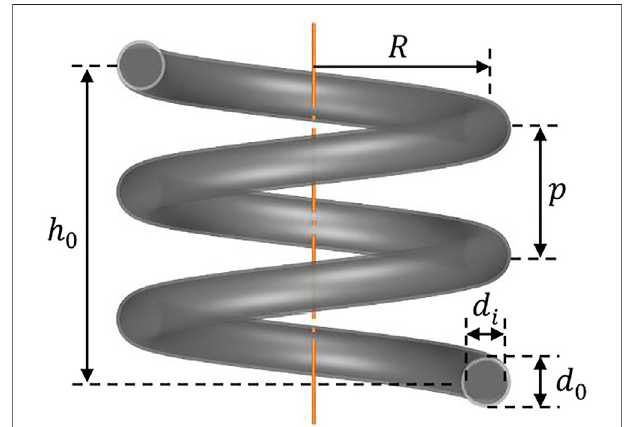
FIGURE 2 | (A) Spring-solenoid system and generated magnetic fi eld, (B) in-plane magnetic fi eld produced by the solenoid and the cross-section motion during spring elongation, (C) shear mode of MR fl uid